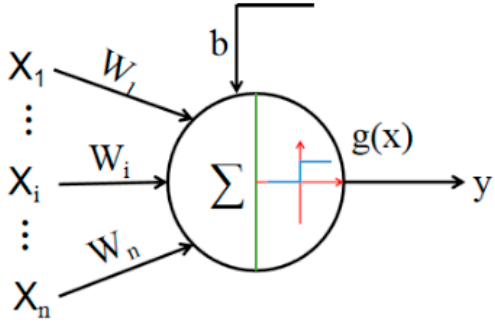
Figure 6. The output of a neural network.